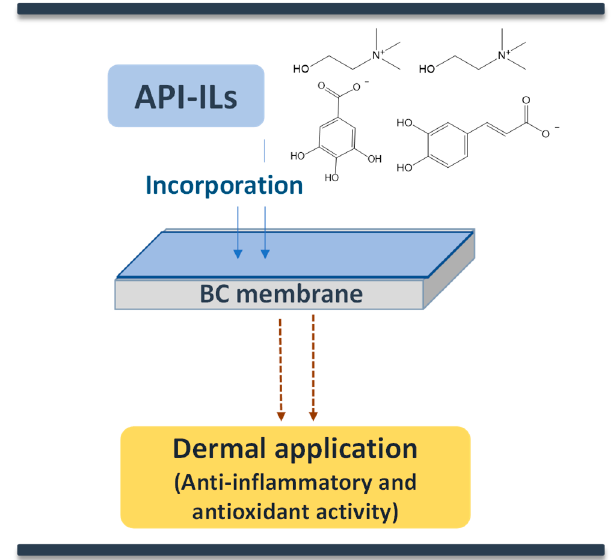
Figure 20. Illustration of BC-IL membranes’ with antioxidant and anti-inflammatory action for dermal application proposed in [202].